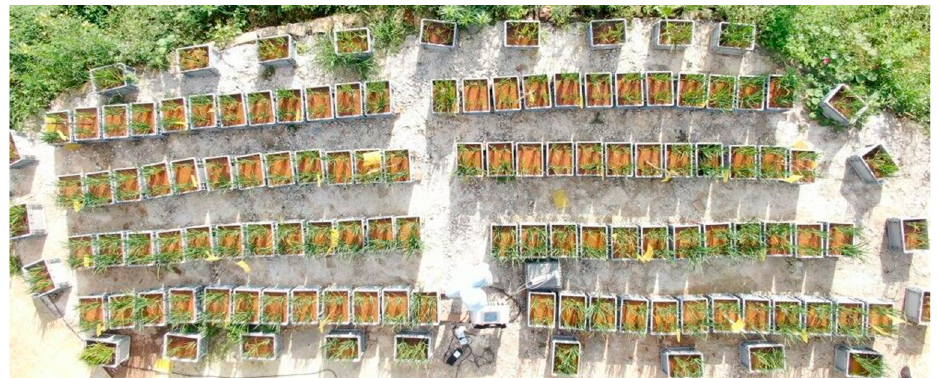
Figure 1. Aerial photo of rice potting experiment.